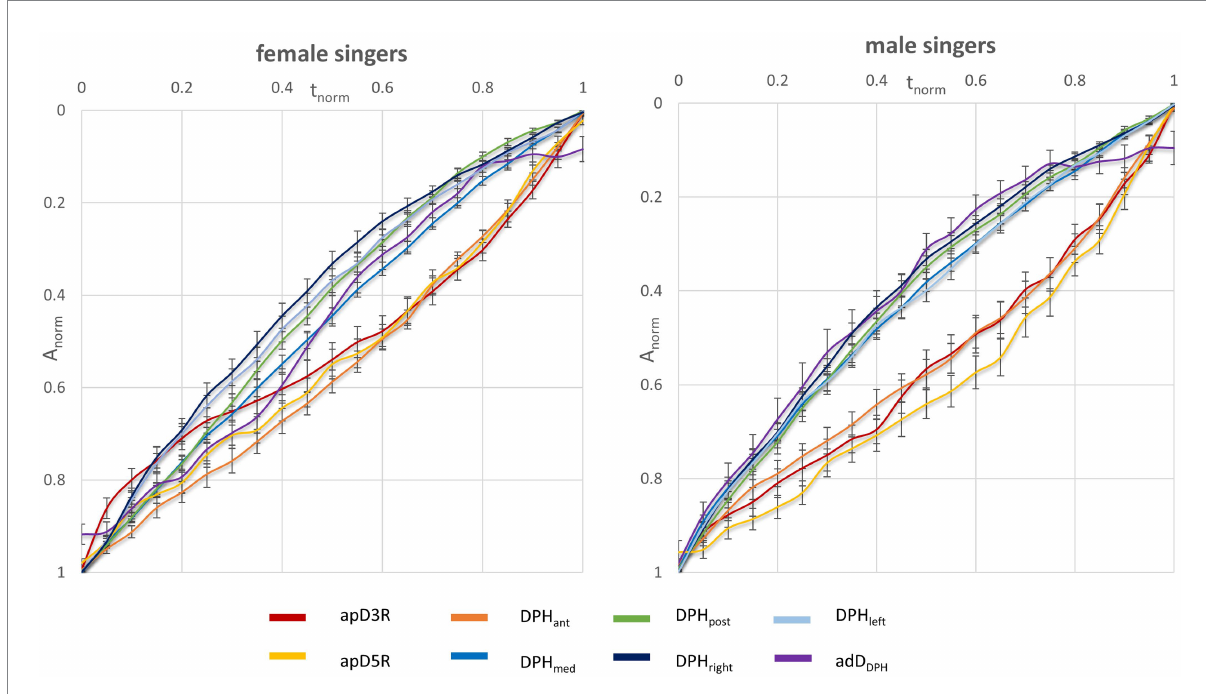
FIGURE 3 No major difference in movement velocities during sustained phonation between female and male singers. The figure displays the normalized amplitude ( A norm ) of the mean movement curves for different locations for male (right) and female singers (left) as a function of normalized phonation